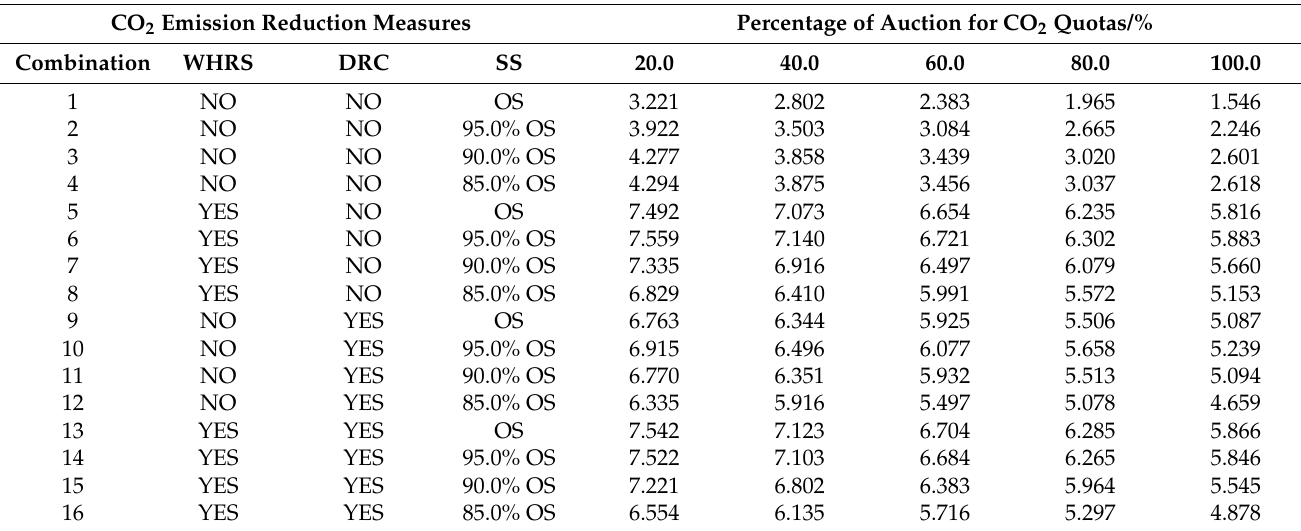
Table 6. Annual income of the container ship with different combinations of CO 2 emission reduction measures in 2030.